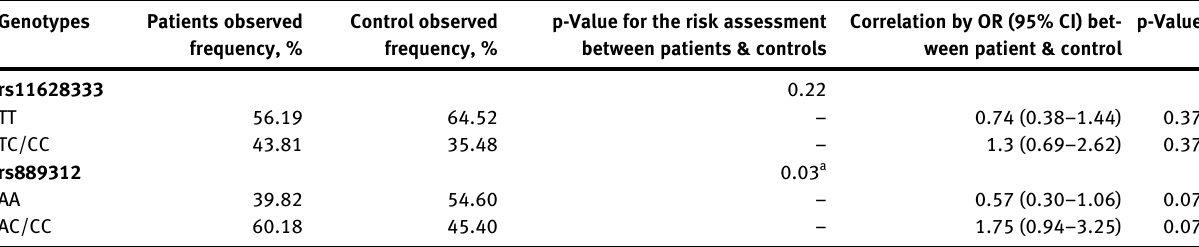
Table  : Risk assessment of MAPK polymorphism, rs  and rs  with combined genotype frequency calculation and OR correlation of combined genotype effect its association with risk of breast cancer.